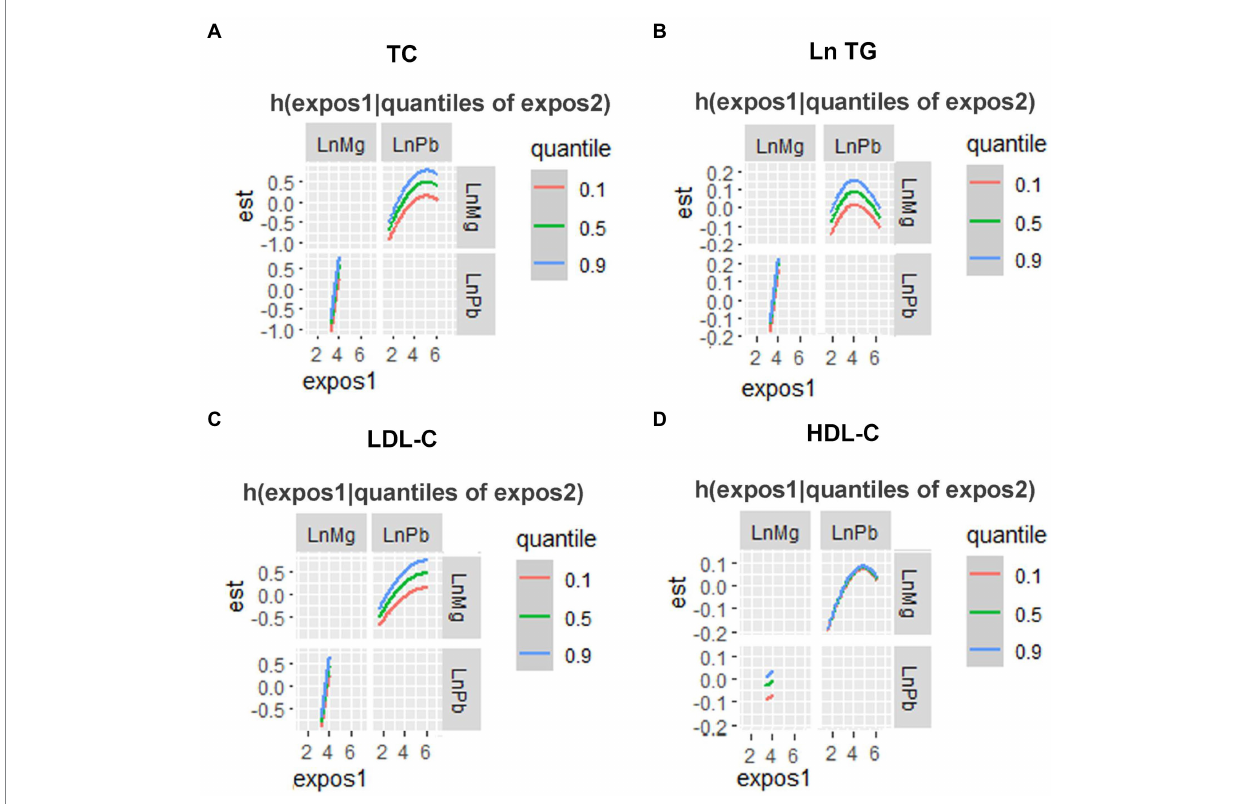
FIGURE 5 The bivariate associations of Mg and Pb exposure-response relationships of a single metal where the second element was fixed at P10, P50 and P90 analyzed by the BKMR model. (A) TC, (B) Ln TG, (C) LDL-C, and (D) HDL-C. TG, blood Pb and essential metal concentrations were transformed to natural logarithm for further analysis. The model was adjusted for age, sex, educational, smoking status, abuse drinking, BMI categories, diabetes, and hypertension. TC, total cholesterol; TG, triglyceride; LDL-C, low-density lipoproteins cholesterol; HDL-C, high-density lipoproteins cholesterol; BMI, body mass index; Mg, magnesium; Pb,